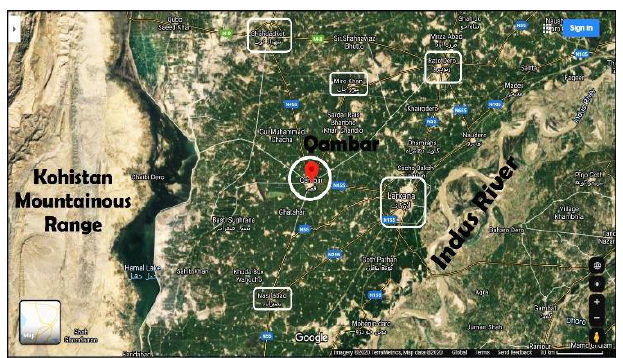
Fig. 2. Location map of Qambar within geographical region of Indus River, Sindh Pakistan Qambar bounded by three distinct landforms locally known as ‘Litaaso’, ‘Kaacho’ and ‘Kohistan’. Litaaso is eastern part of city developed due to floods in Indus River since time immemorial and as a result emerged different water bodies and alluvial soil of Qambar making this area fertile for production of agriculture- based crops. Nature of soil in ‘Litaaso’ is 16% clay, 64% silt and 30% sand. ‘Kaacho’ makes city’s western bound until ‘Hamal’ Lake. Soil types in ‘Kaacho’ is 50% clay, 40% silt and 10% sand. ‘Kohistan’ consists of mountainous range with limestone, sandstone, and igneous rocks [82]. This is dry area and people sustain on domestic animals and birds for their livelihood. The climate in summer is very hot and in winter quite